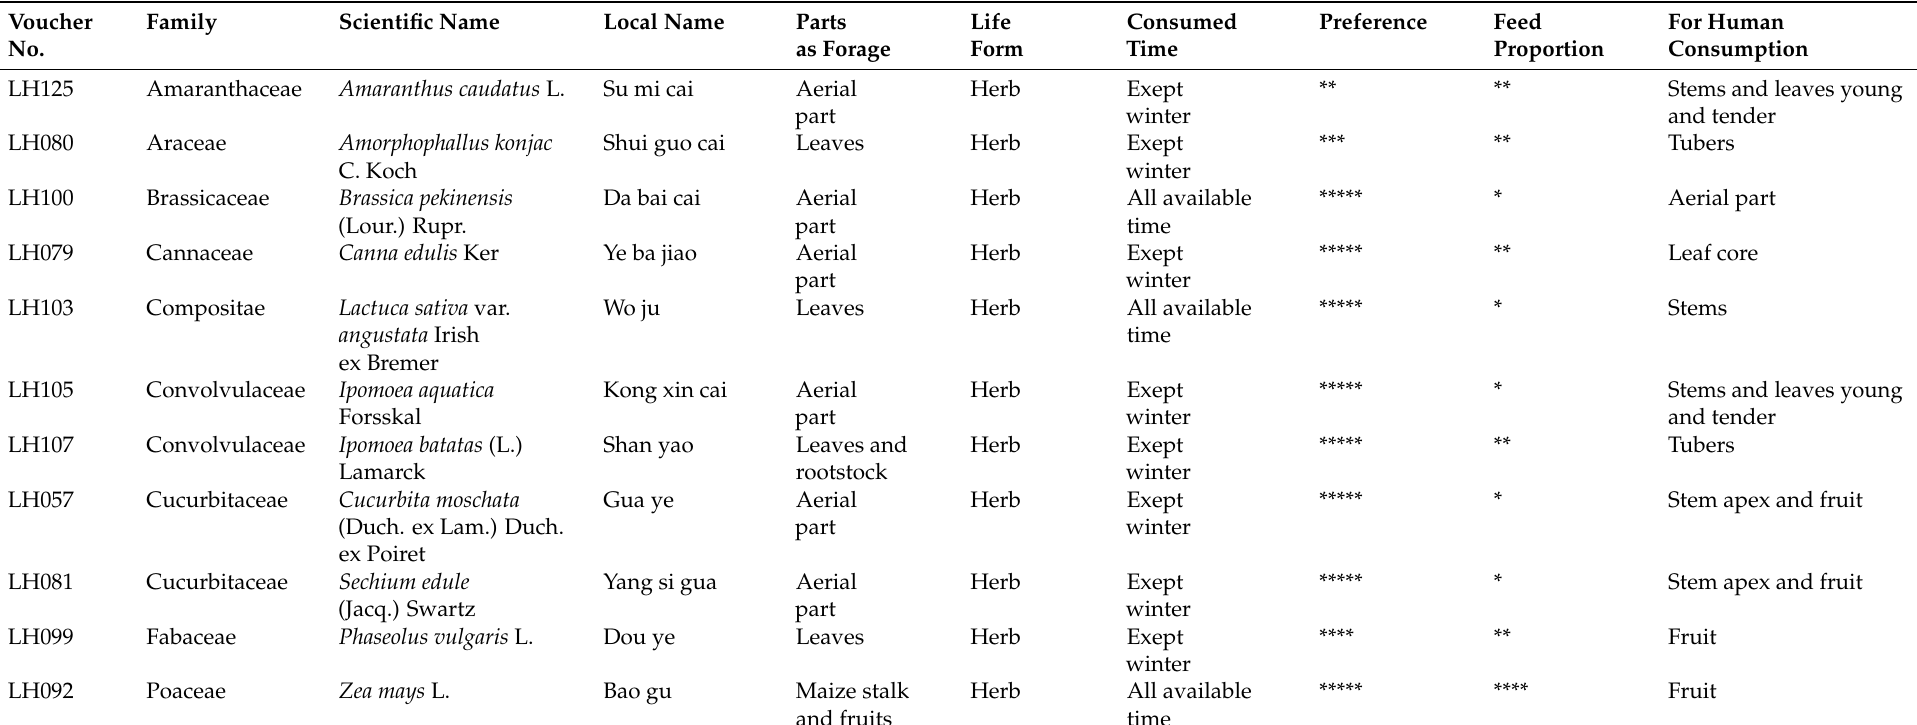
Table 3. Inventory of cultivated plants as Gaoligongshan pigs’ forage and as human